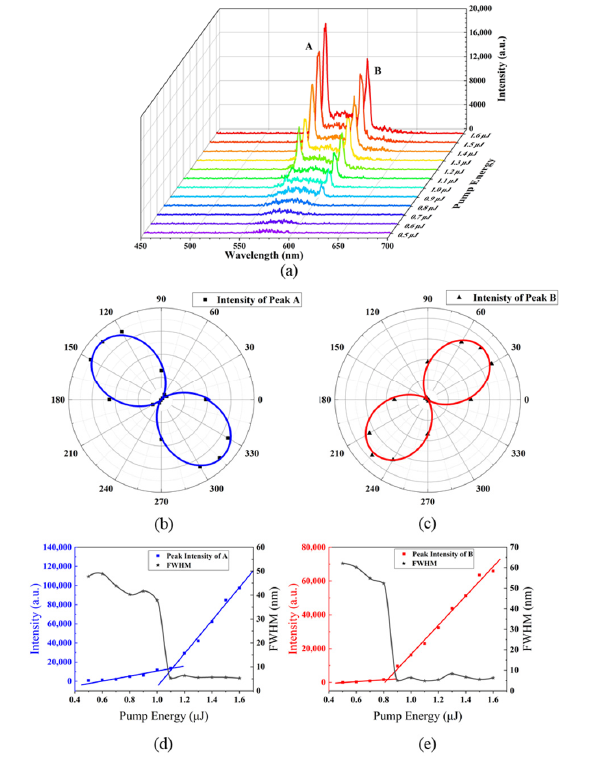
Figure 6. ( a ) Dual ‐ wavelength laser emission spectra of sample F for different pump energies at 28 °C; ( b , c ) the polarization states of Peaks A and B, respectively; ( d , e ) the dependence of emission intensity and FWHM of Peaks A and B as a function of pump energy, respectively. Figure 6d,e depict the integrated intensities of the RCP and LCP emission peaks and their corresponding full widths at half maximum (FWHM) for the dye ‐ doped superstruc ‐